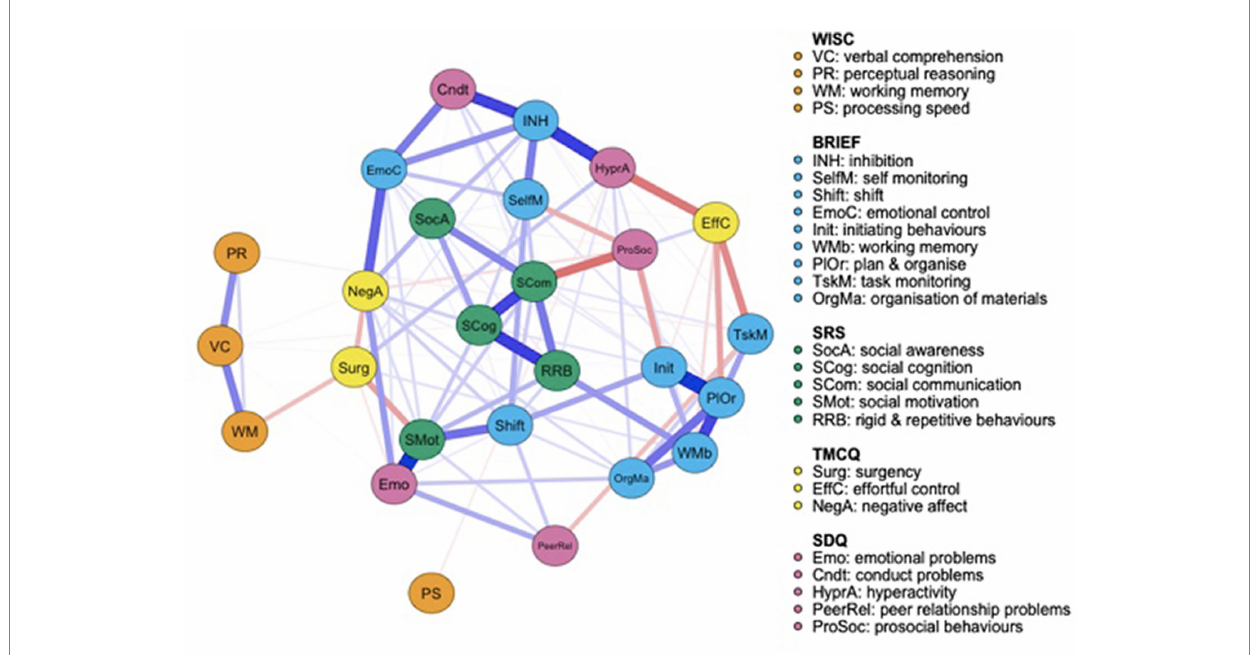
FIGURE 1 Full term control group network structure of autism spectrum condition (ASC) symptomatology and cognitive, executive functioning, temperament and psychopathology outcome variables. Networks consist of round elements (nodes) which correspond to variables. Lines connecting each node (edges) represent partial correlations between nodes.